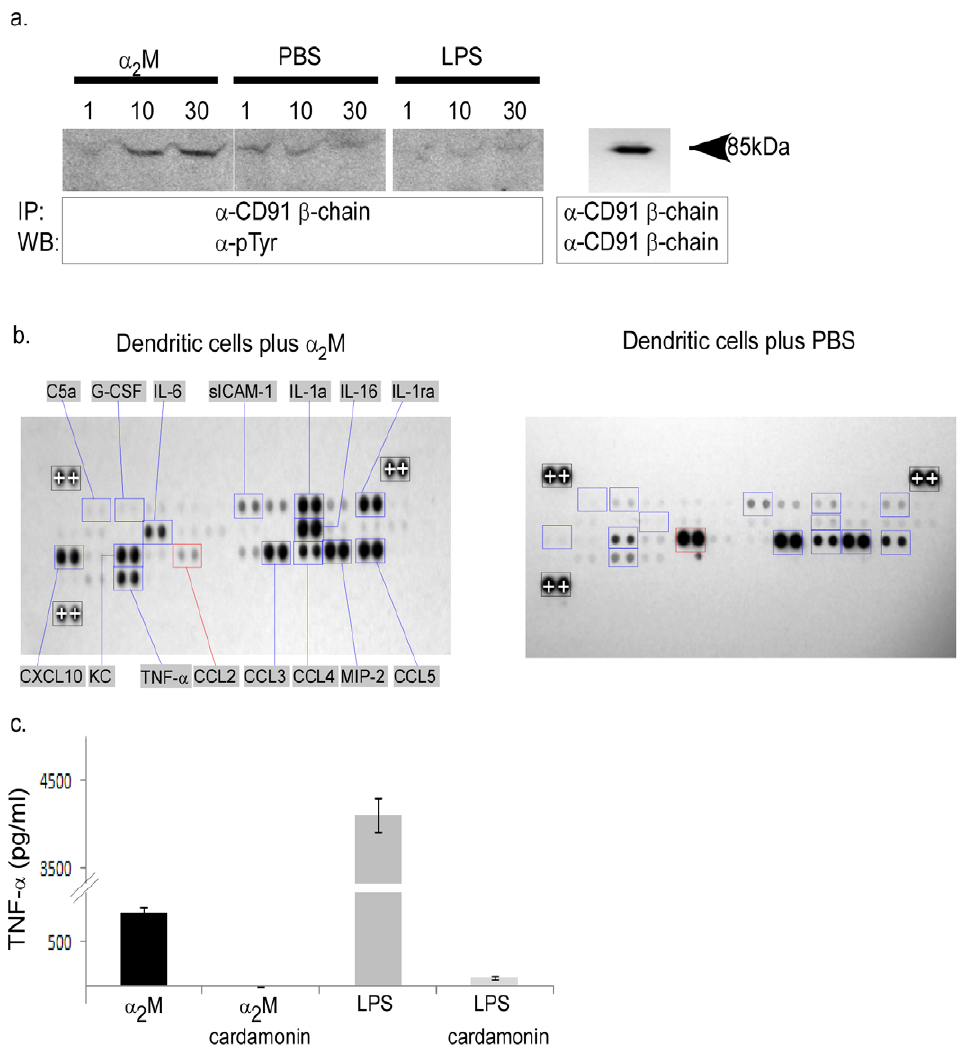
Figure 3. a 2 M provides signals necessary for T cell priming. a) RAW264.7 cells were pulsed with a 2 M, LPS or PBS. The b -chain of CD91/LRP-1 was immunoprecipitated and probed with a -pTyr antibodies. b) Splenic dendritic cells were pulsed with a 2 M (left panel) or PBS (right panel) for 20 h. Supernatants from either culture were incubated with cytokine profiler arrays as described in Methods and developed. Signals higher (blue boxes) or lower (red boxes) than background (PBS pulsed cells) are highlighted. Standardization signals on each blot (with + signs in Black boxes) are used to normalize signals to each other. c) Splenic dendritic cells were pulsed with a 2 M or LPS in the presence or absence of the NF- k B inhibitor cardamonin for 20 h. Supernatants were analyzed by ELISA for TNF- a . Error bars represent standard deviation of